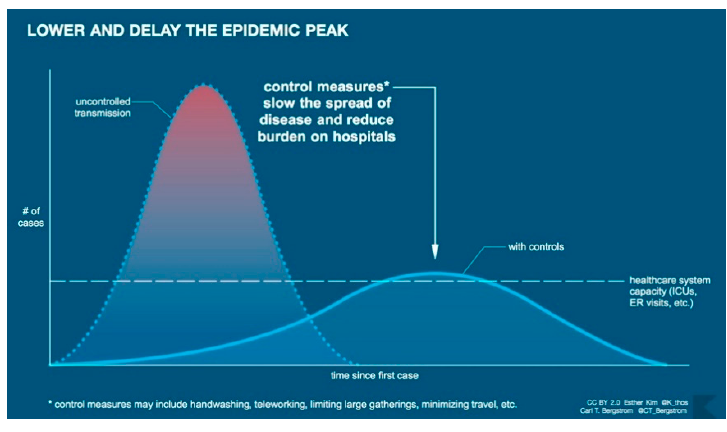
Figure 9. Flattening the curve [65].